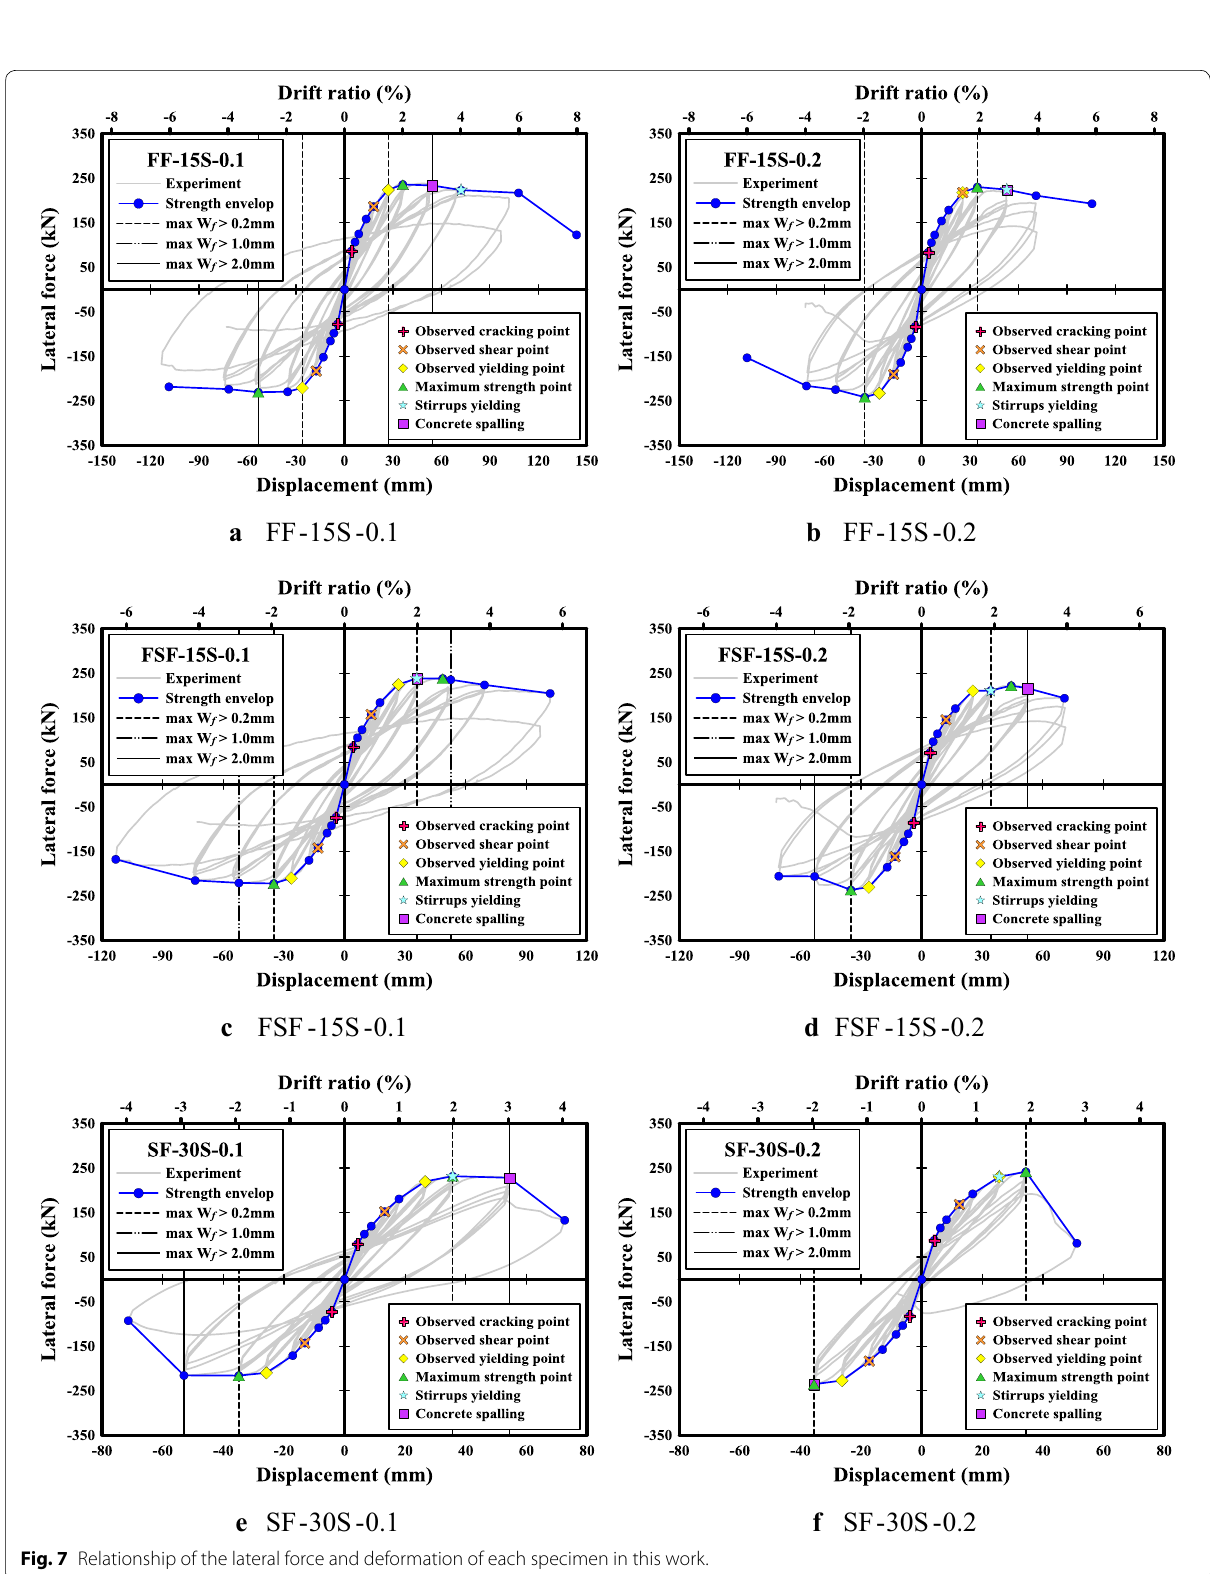
Fig. 7 Relationship of the lateral force and deformation of each specimen in this